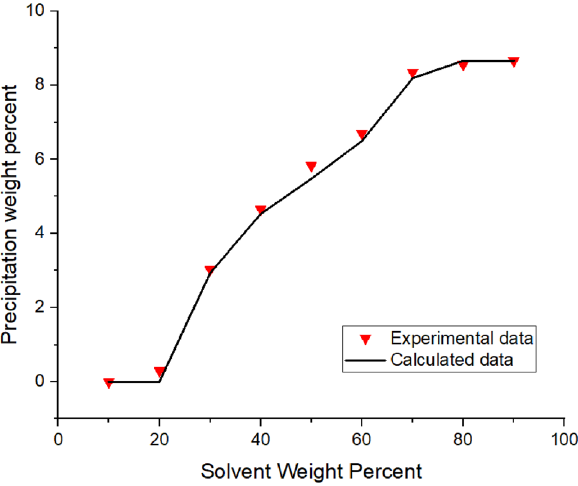
Figure 1. Asphaltene precipitation from the oil sample A versus solvent percent: obtained from experimental and modeling